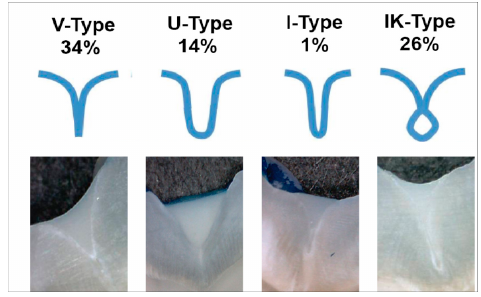
Figure 1. Different shapes of fissures.